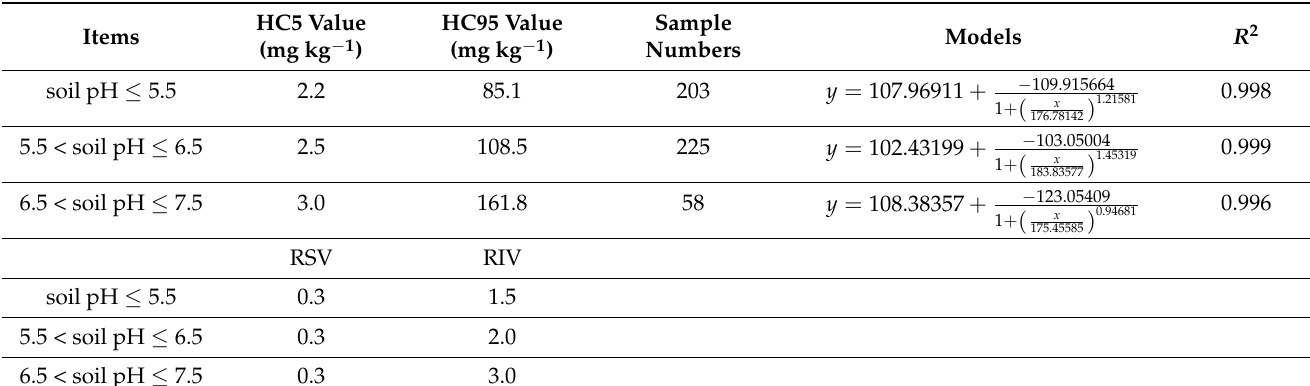
Table 3. The estimated HC5 and HC95 values of maize-planted soil, the risk screening value (RSV), and the risk intervention value (RIV) of Cd in the Chinese Soil Environmental Quality Standards (EQSs) with different soil pH